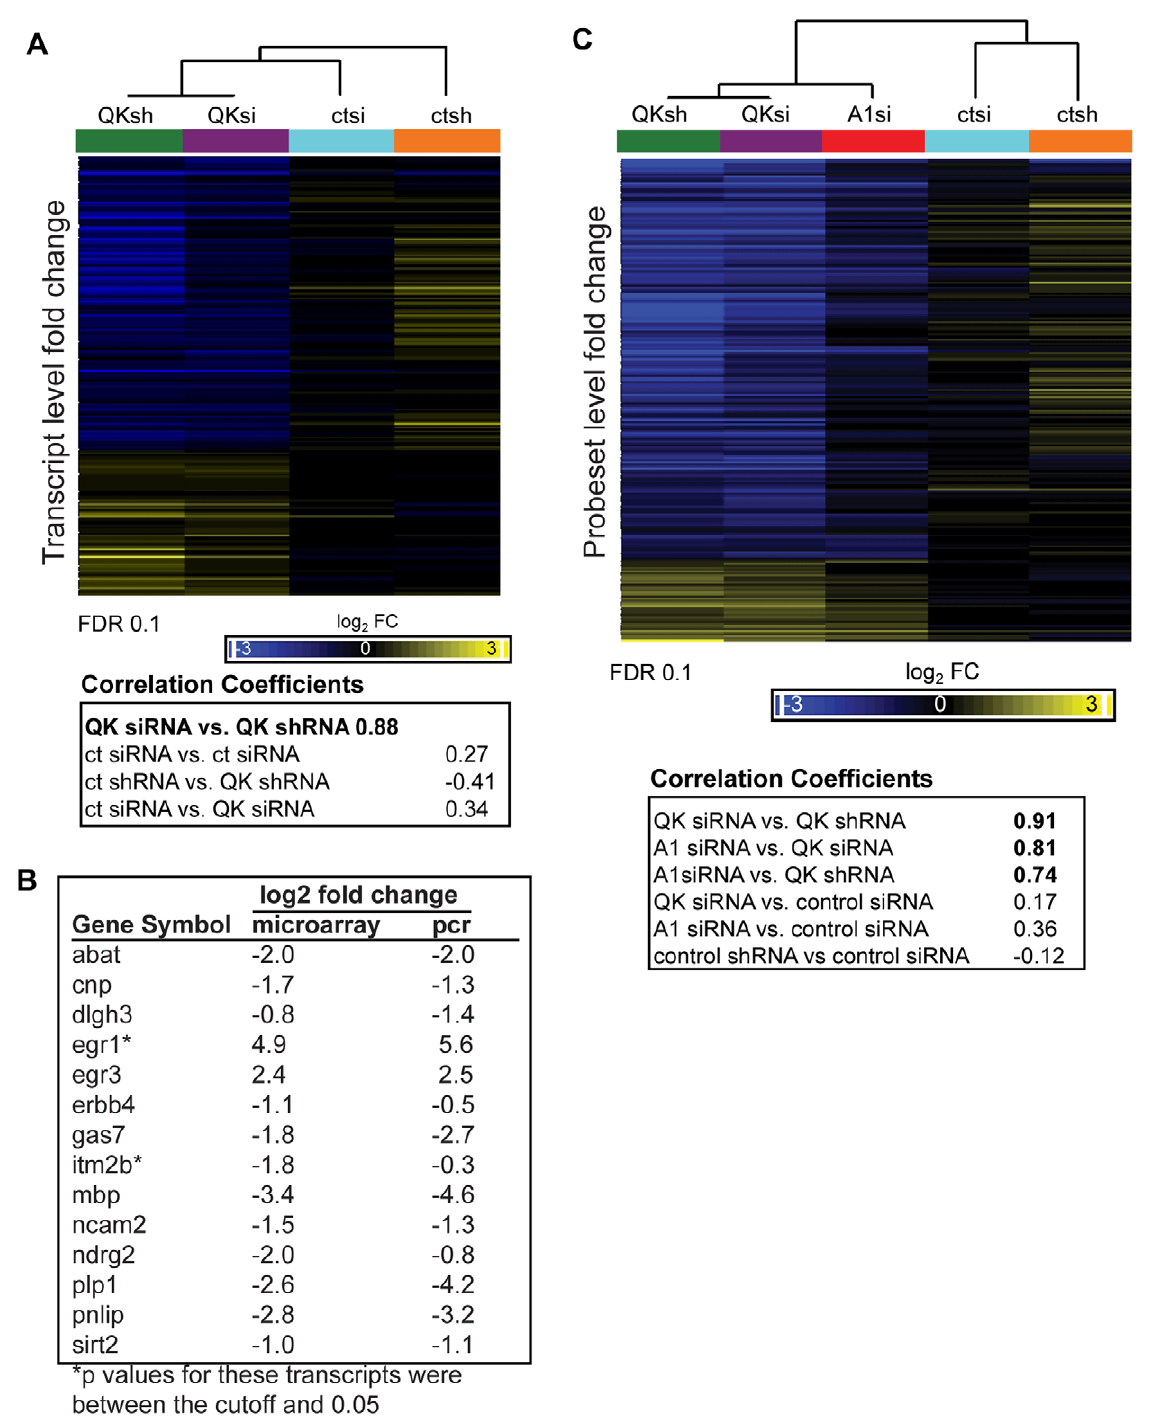
Figure 7. Identification of the QK and hnRNP A1 regulatory networks in CG-4 cells. (A) Hierarchical clustering demonstrated high correlation in the gene expression changes between the two knockdown populations. Transcripts altered by QK depletion were identified using a two sample t-test and an FDR of 0.1 (p-value cutoff 0.0012). For the selected transcripts, the expression values of the three biological replicates were averaged and the fold change compared to untransfected CG-4 cells was calculated. The resulting values were clustered (Pearson’s dissimilarity, centroid method), and correlation coefficients were calculated. (B) Real time PCR confirmation of microarray results. RNA was extracted from the Qk shRNA miR knockdown cell line and from the nonsilencing shRNA miR control cell line. Real time PCR was performed in triplicate. Expression values were normalized to tubulin as a loading control. Data are the mean of three replicates, expressed at log2 for comparison to the microarray results. (C) QK- dependent probeset expression changes are highly correlated with probeset expression changes caused by hnRNP A1 depletion. Individual probesets with expression changes in response to QK knockdown were identified using a two-sample t-test, comparing the knockdown groups to the control groups. The mean of each group was determined and the difference from the CG-4 cell line was calculated. Values were clustered as in (A). Correlation coefficients were calculated using Partek GS software. Probesets were selected for clustering based solely on their change in the QK knockdown samples.